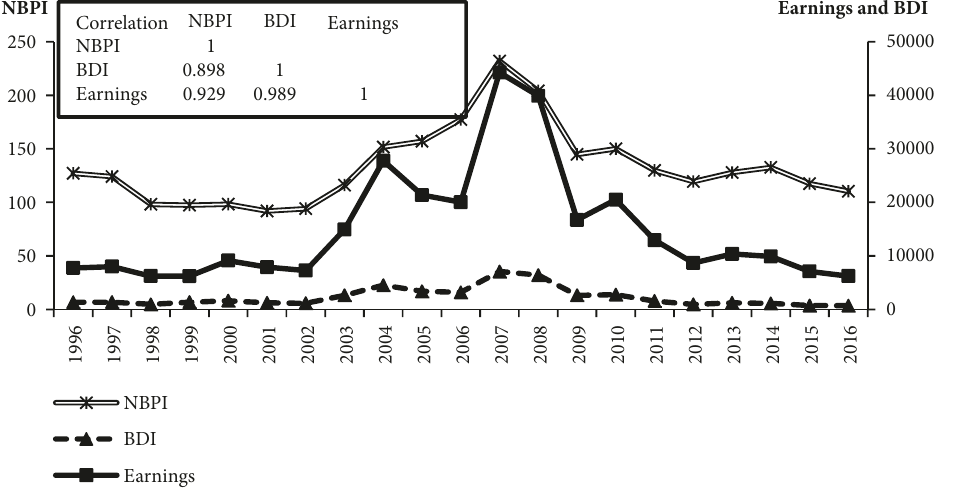
Figure 2: Correlations between new-building price, BDI, and earnings in the bulker